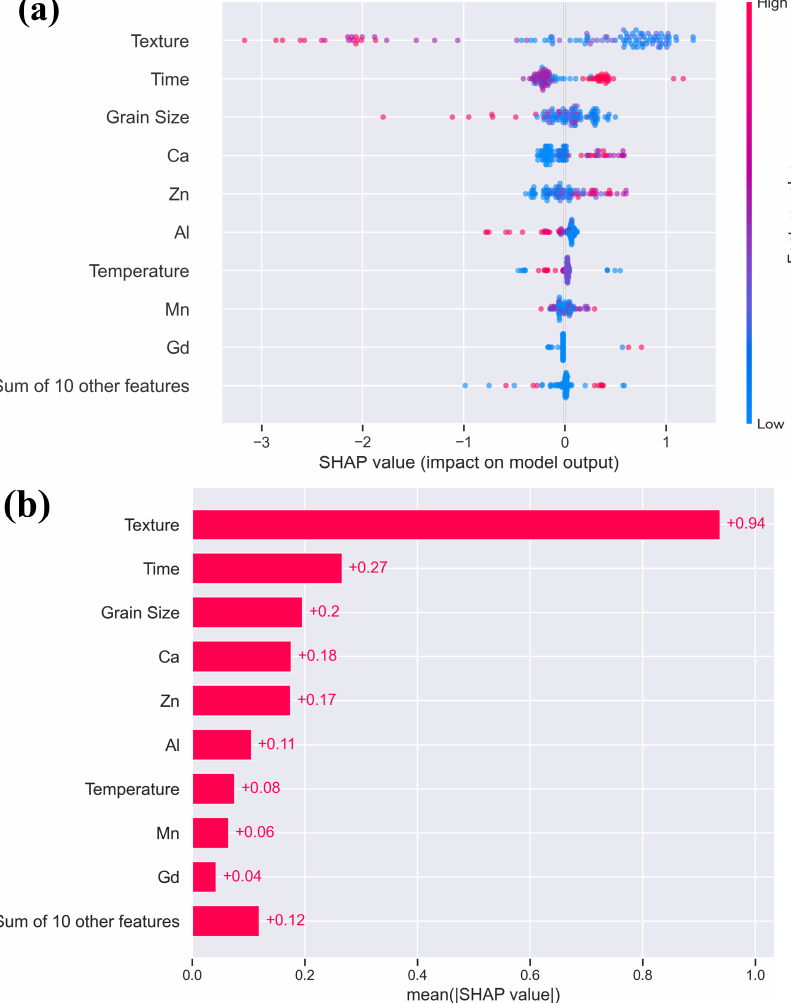
Figure 4. The feature analysis via SHAP method. ( a ) SHAP value distribution of different samples, ( b ) Feature importance ranked by SHAP value.